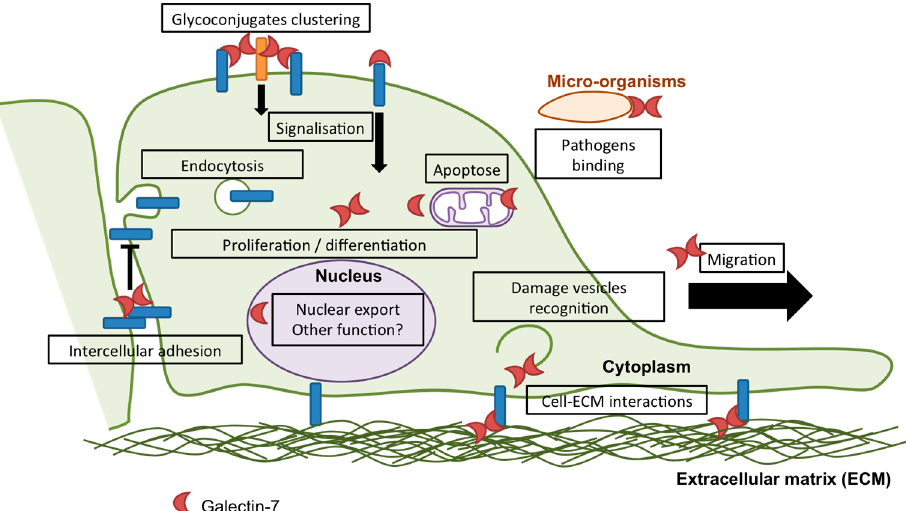
Figure 2. Schematic representation of known and putative functions of galectin-7. In addition to the functions of galectin-7 in cell proliferation, apoptosis, differentiation, migration and adhesion described in this issue, few evidence highlights other functions of galectin-7 in epithelia. As an illustration, galectin-7 has been shown to interfere with Transforming Growth factor β (TGF β ) signalling in response to Hepatocyte Growth Factor (HGF) by promoting smad3 export from the nucleus and thus preventing liver fibrosis occurrence [45]. In addition, the commensal bacteria Finegoldia magna has been described to adhere to the upper layers of the epidermis through binding of the adhesion bacterial protein F. magna Adhesion Factor (FAF) to galectin-7, indicating that galectin-7 can bind to ligands from microbial origin [46].